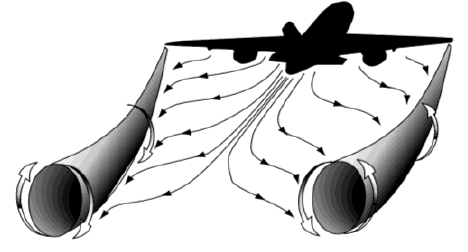
Fig. 1 Formation of Wake